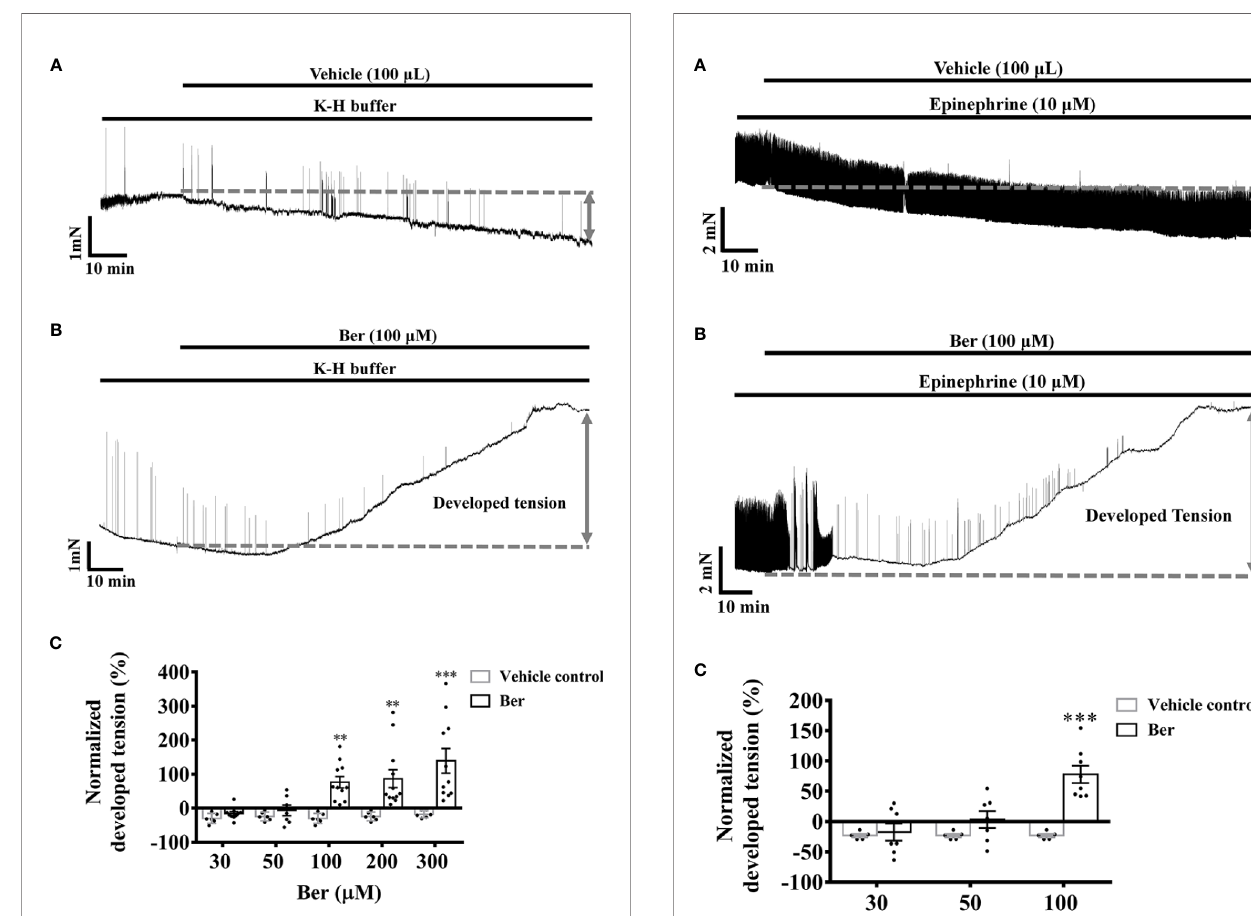
FIGURE 2 | Berberine increased the tension of freshly isolated left ventricular muscle (LVM) strips . (A, B) Original isometric tension recordings showing that berberine (100 µM) increased the tension of LVM strips. (C) Summary data showing that berberine increased the tension of LVM strips in a concentration-dependent manner. The numbers of repeats are as follows: 30 µM Ber, n = 10, N = 10; 50 µM Ber, n = 7, N = 7; 100 µM and 300 µM Ber, n = 11, N = 11; 200 µM Ber, n = 12, N = 12; n and N are the numbers of LVM strips and rats, respectively. Ber stands for berberine. * *p < 0.01 , ***p < 0.001 vs. vehicle control group; two-way ANOVA with Sidak's multiple comparisons test.